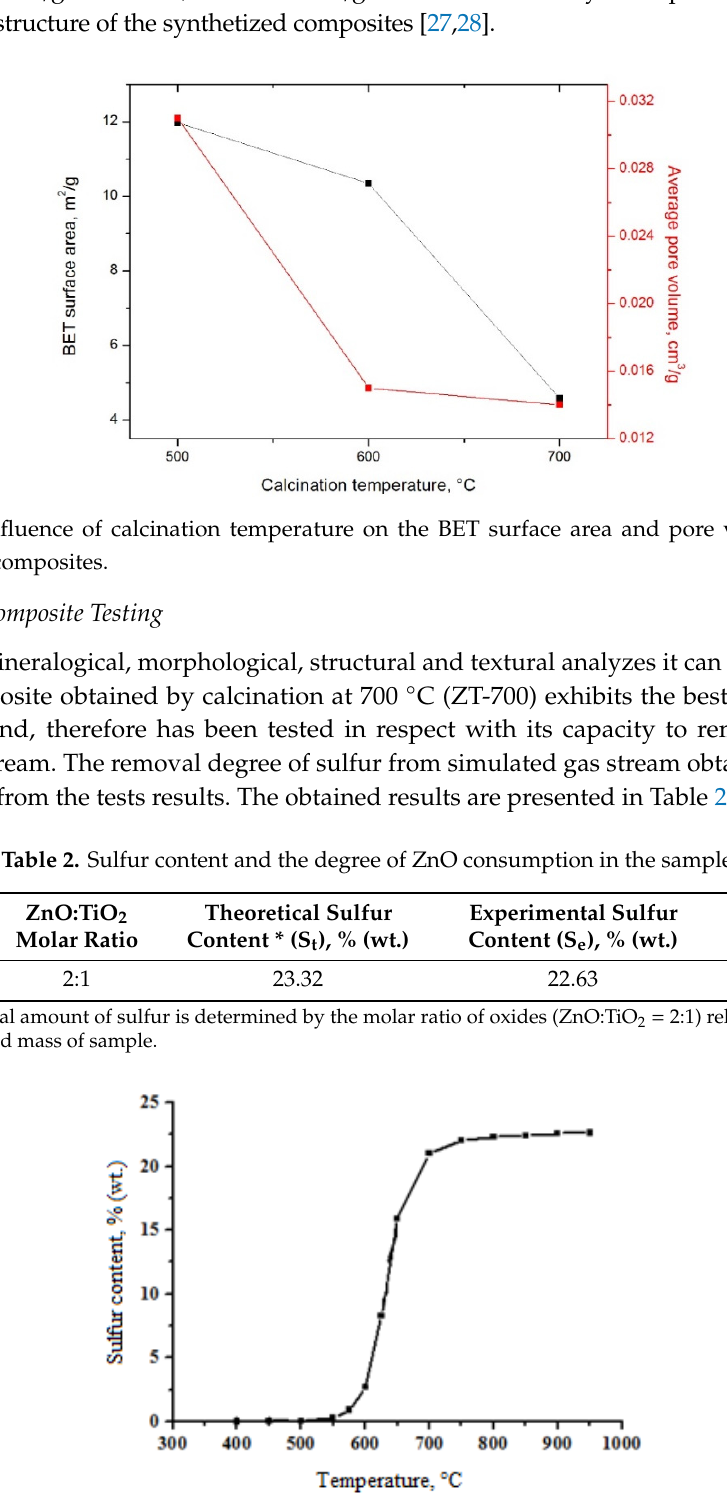
Figure 8. The amount of sulfur removed from the ZT-700 as a function of the calcination temperature.